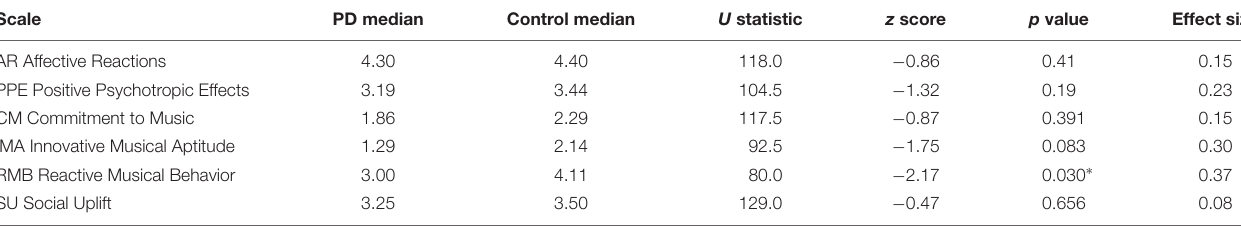
TABLE 2 | Two sample Mann–Whitney U test results for the domains of the BMEQ.